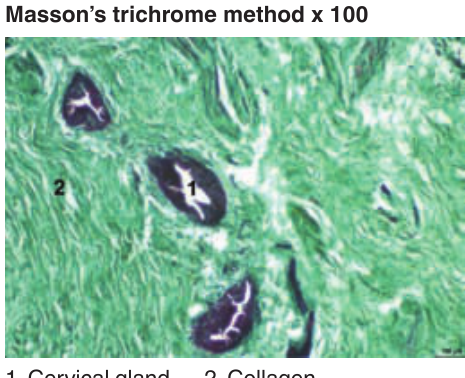
Fig. 5. Longitudinal section of cervix.